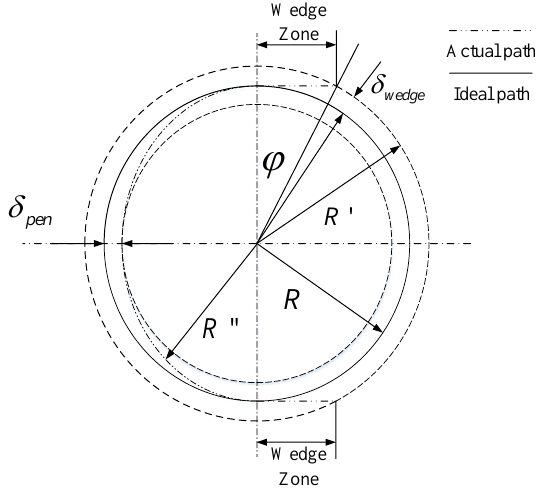
Figure 2. Geometry of bands and segments travelling in a wrap angle.